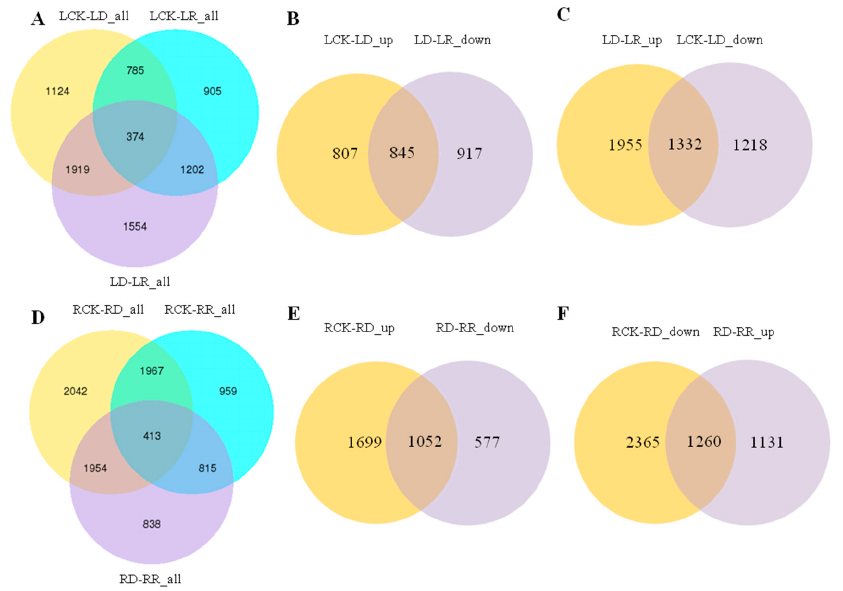
Figure 4. Venn diagrams showing the numbers of di ff erentially expressed genes (DEGs) co-modulated in leaves and roots following drought stress and re-watering treatment. ( A ) Venn diagrams showing DEGs between watered control (LCK), drought (LD) and re-watering (LR) treatments in leaves. ( B ) Venn diagrams showing DEGs between LCK-LD-up and LD-LR-down. ( C ) Venn diagrams showing DEGs between LCK-LD-down and LD-LR-up. ( D ) Venn diagrams showing DEGs between watered control (RCK), drought (RD) and re-watering (RR) treatments in roots. ( E ) Venn diagrams showing DEGs between RCK-RD-up and RD-RR-down. ( F ) Venn diagrams showing DEGs between RCK-RD-down and RD-RR-up.